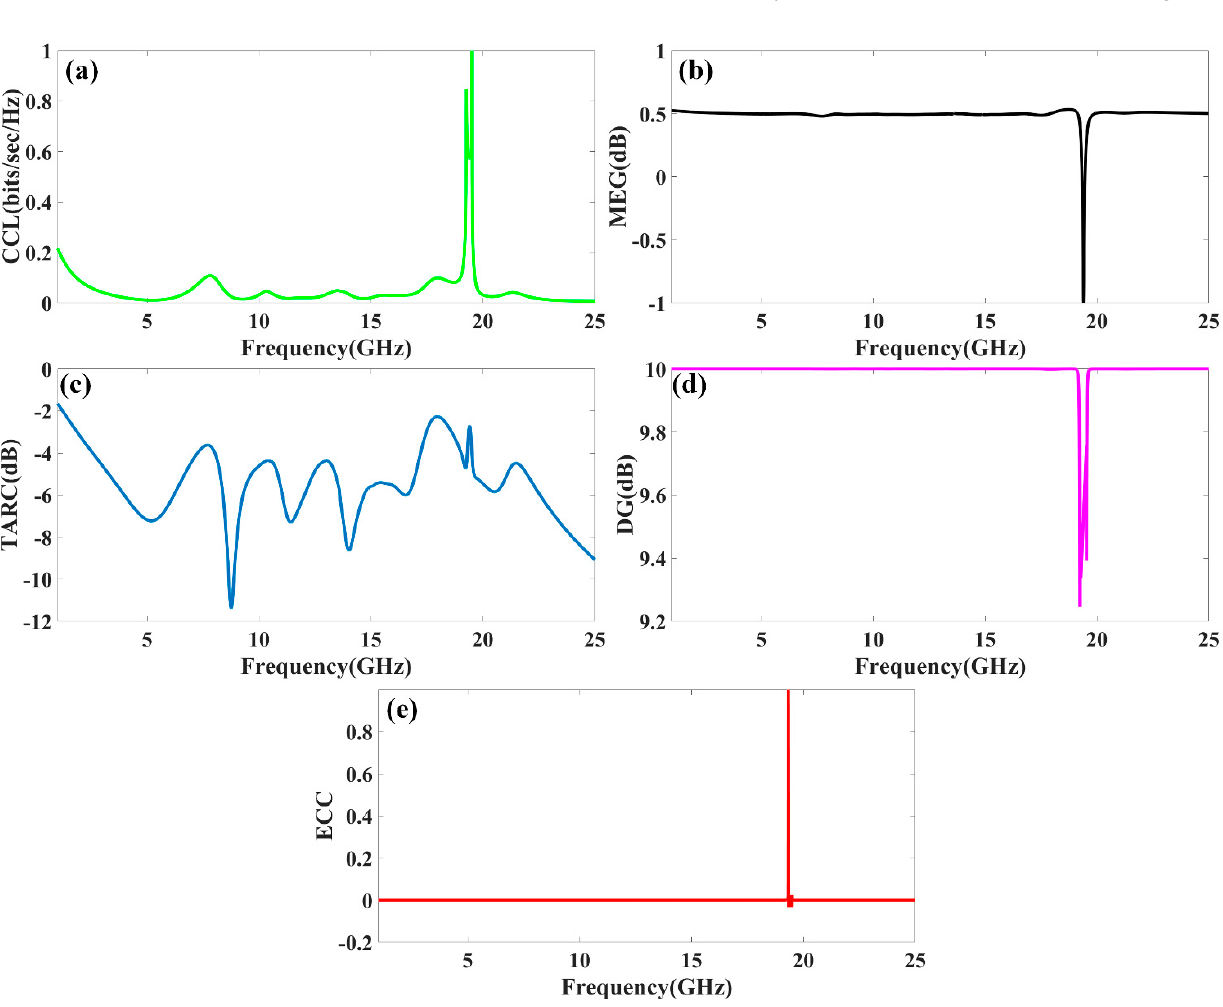
Figure 12. Variation in antenna radiation efficiency (measured) for different antenna designs.